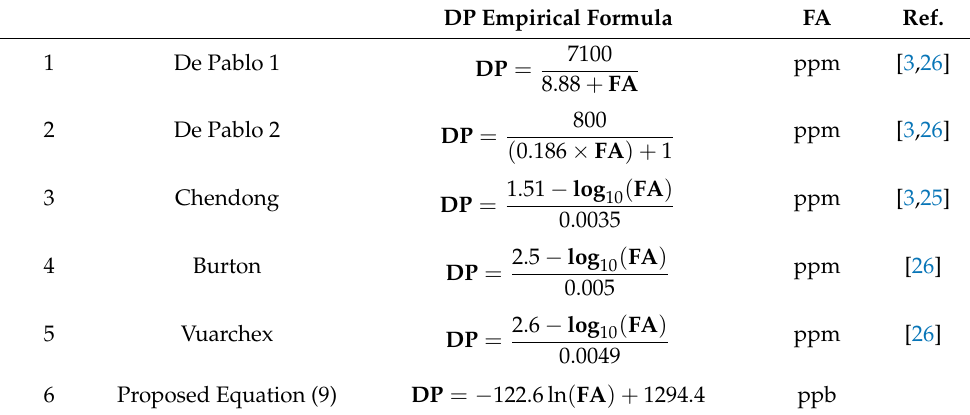
Table 6. Empirical DP expression that is used for comparison with Equation